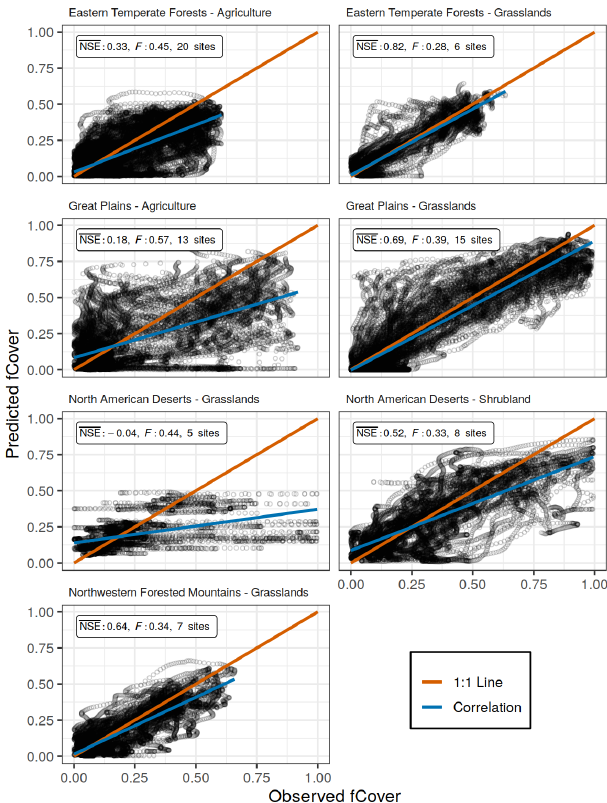
Figure 4. Observed and predicted daily fCover values for models from seven spatial scales, for which only specific vegetation types within a single ecoregion were used in model fitting. Each uses all available sites and years with the respective spatial scale. NSE is the average Nash–Sutcliffe coefficient of efficiency among sites, and F is the mean coefficient of variation of the mean absolute error. The correlation line (blue) represents the overall trend in predicted versus observed values, while the 1 : 1 line (red) represents a perfect fit.